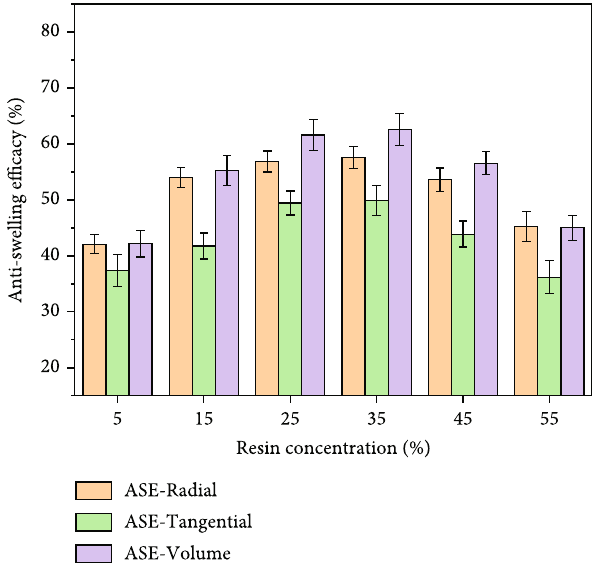
Figure 5: Antiswelling e ffi cacy of the di ff erent treated